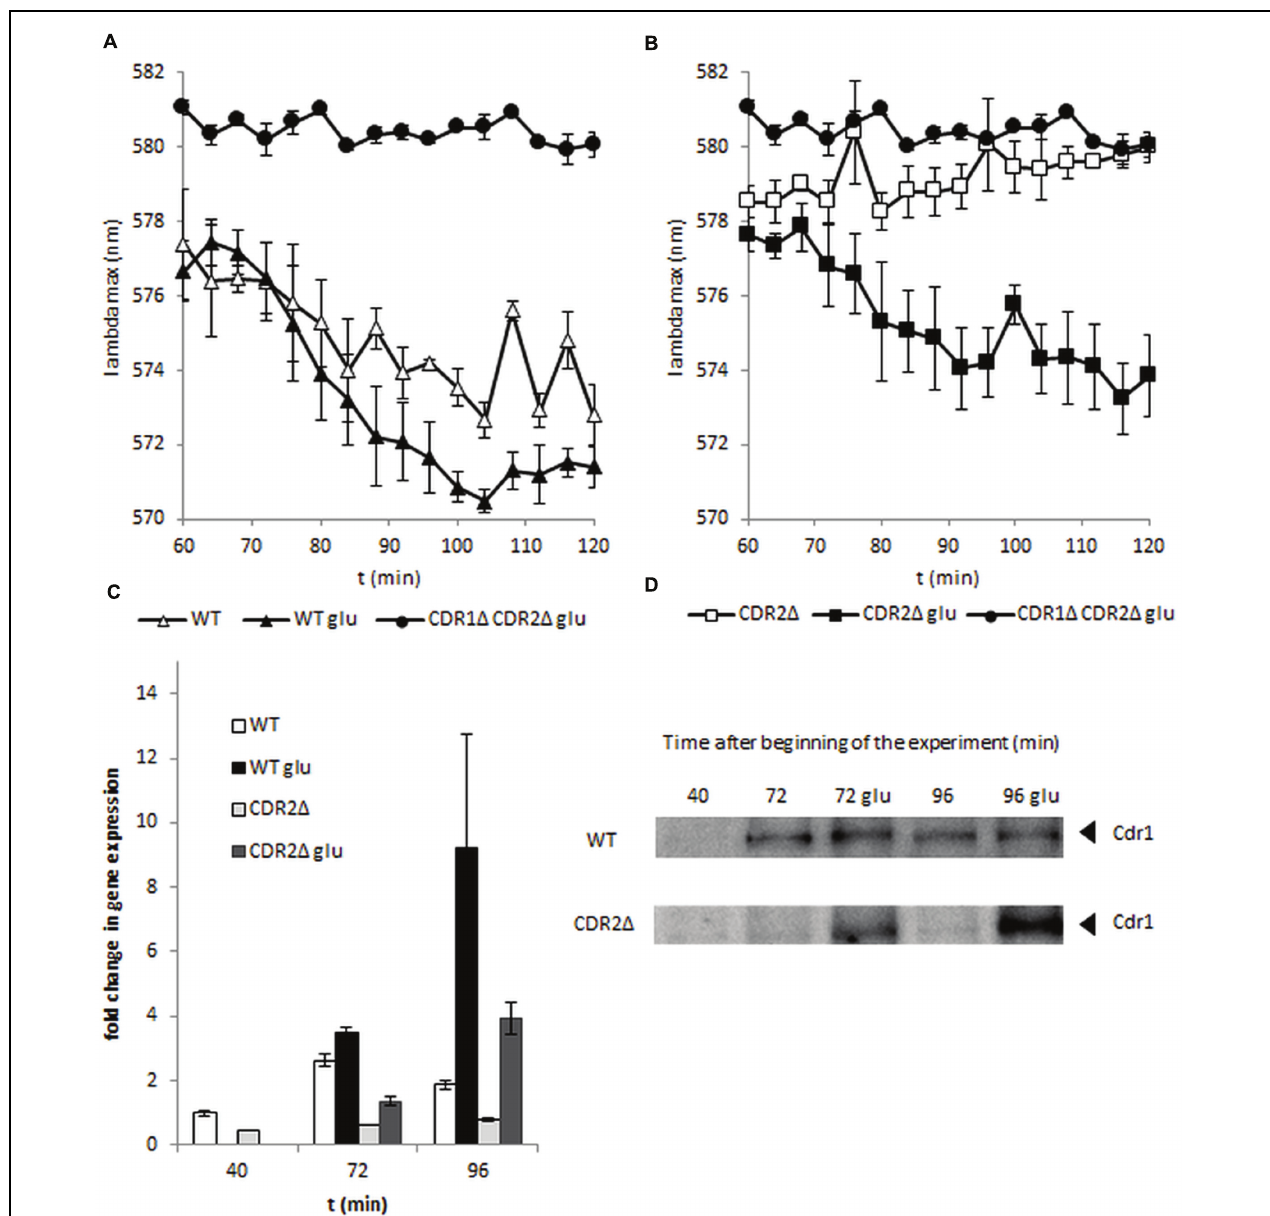
FIGURE 2 | DiS-C3(3) fluorescence staining of wild-type (A) and CDR2 (cid:2) (B) strains during early log-phase. Glucose was added after 60 min of staining. (C) Expression of CDR1 during the experiment. Samples were taken at 40, 72, or 96 min from the beginning of the experiment. (D) Cdr1 protein levels during the experiment. Samples were taken at 40, 72, or 96 min from the beginning of the experiment ( n =